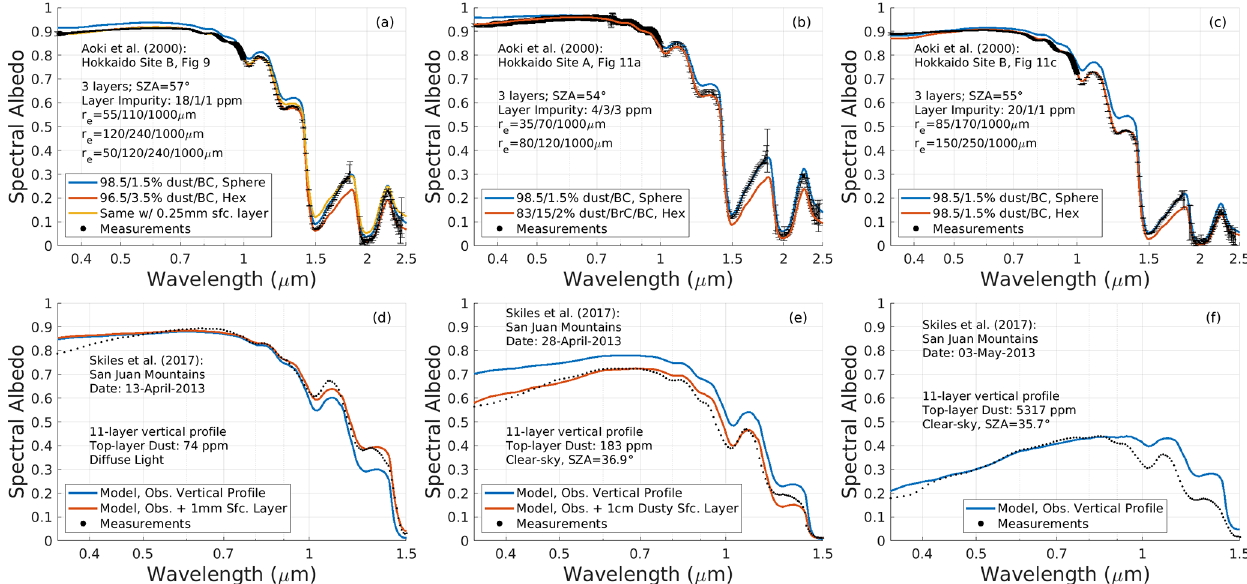
Figure 11. Comparison of modeled spectral snow albedo with measurements from Aoki et al. (2000) (a–c) and Skiles and Painter (2017) (d–f) of snow contaminated with black carbon and dust. The environmental conditions and model parameters for each setting are listed in the panels and described in Sect. 5. The sets of layered effective snow grain sizes ( r e ) for model runs applied in comparison with Aoki et al. (2000) are listed on panels (a) – (c) . Model comparisons with Skiles and Painter (2017) apply their multi-layer measurements of dust, black carbon, and snow grain size at ∼ 3cm vertical